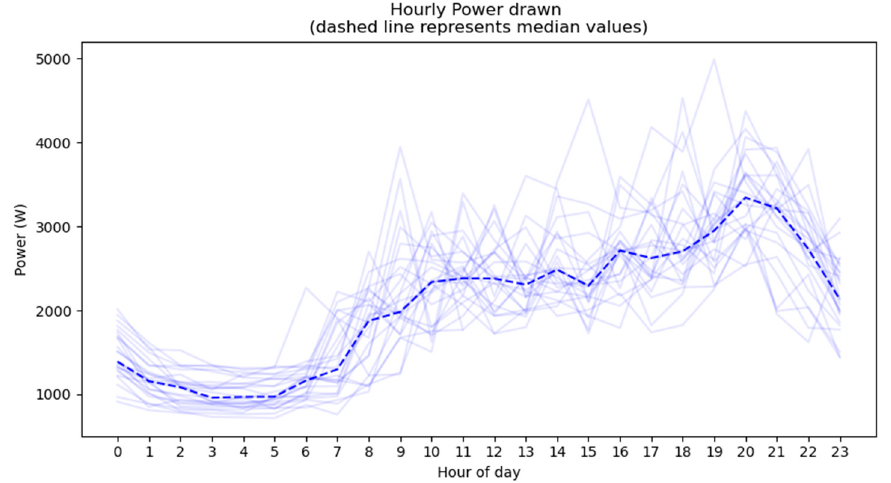
Figure 10. Bunjako daily load profile spanning from July to September 2021.